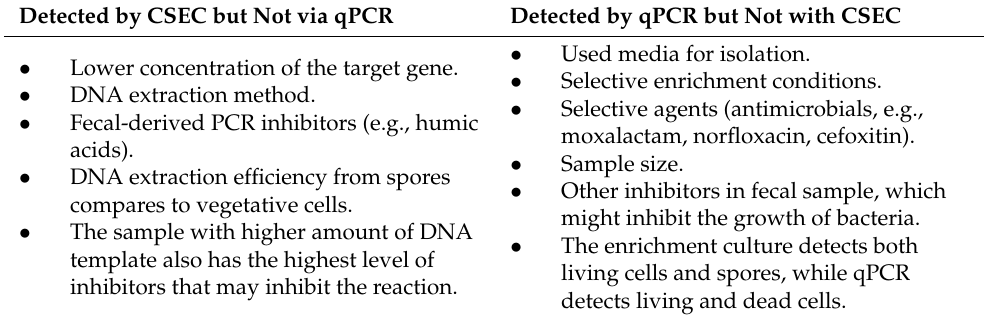
Table 5. Expected reasons for undetectable C. difficile via TaqMan qPCR assay or CSEC method